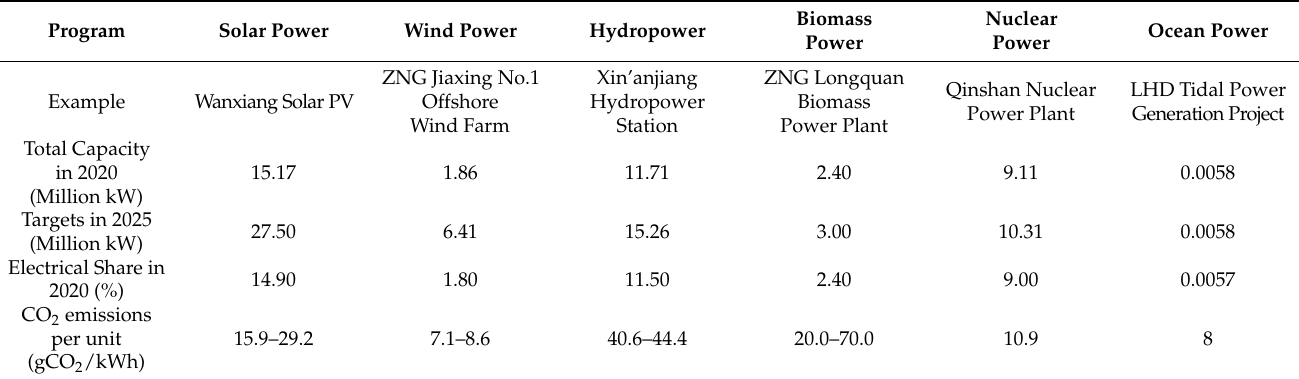
Table 3. Summary of low-carbon technologies for the power sector in Zhejiang